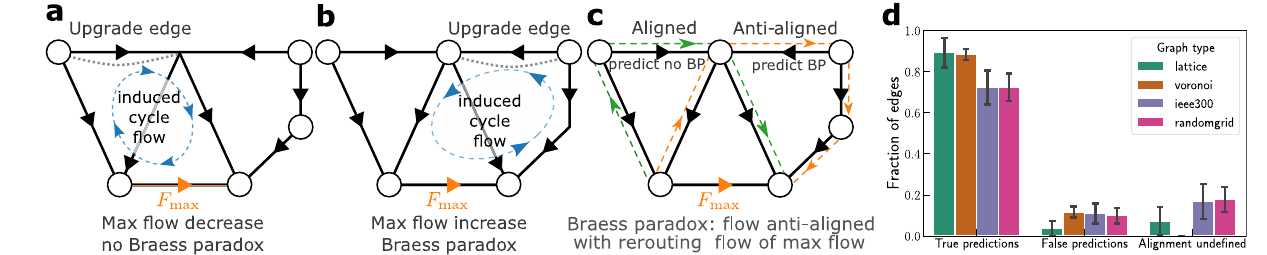
Fig. 3 | Predicting Braessian edges through topological features. a Upgrading edge (2, 3) induces a cycle fl ow that is anti-aligned with the fl ow on the most highly loaded line, thus reducing its load. Hence, Braess ’ paradox does not